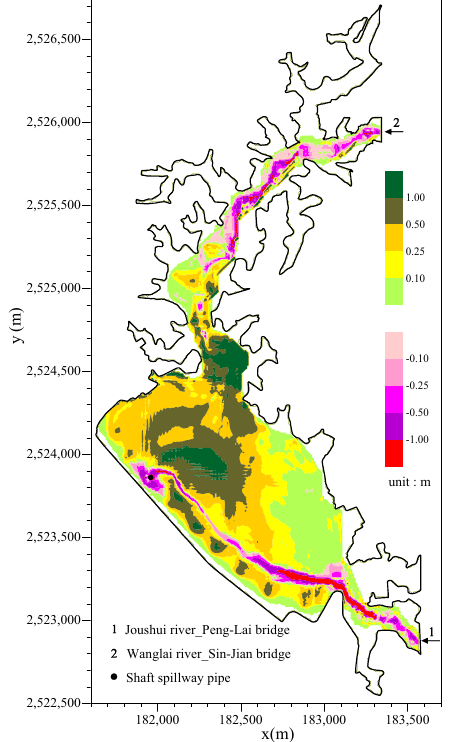
Figure 13. Bed evolution in the reservoir during a 200-year return period, t = 120 h.